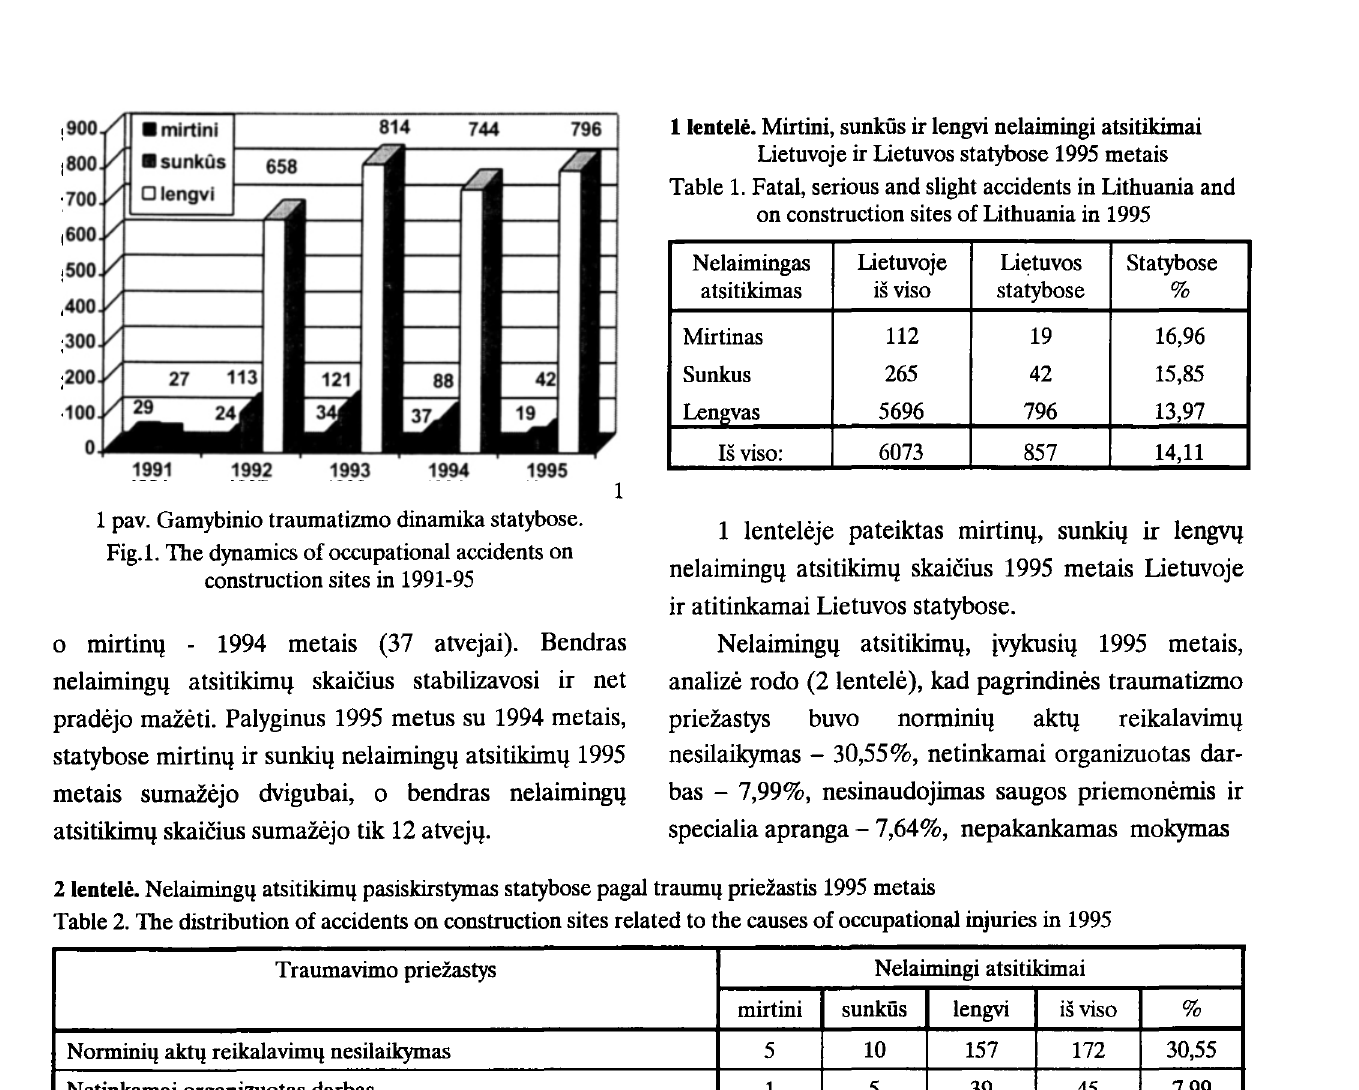
Table 2. The distribution of accidents on construction sites related to the causes of occupational injuries in 1995 Traumavimo priezastys Nelaimingi